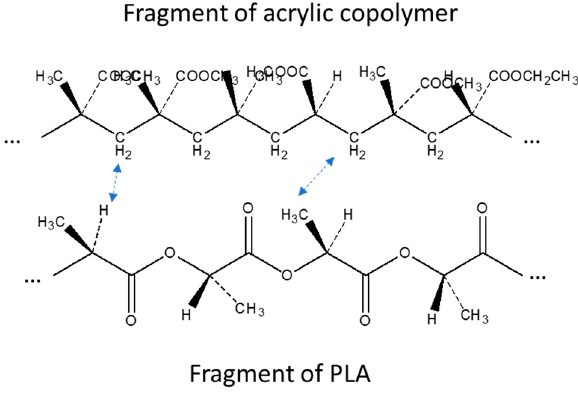
Figure 3. Interactions between PLA and PS acrylic copolymer as deducted by ATR-IR study.